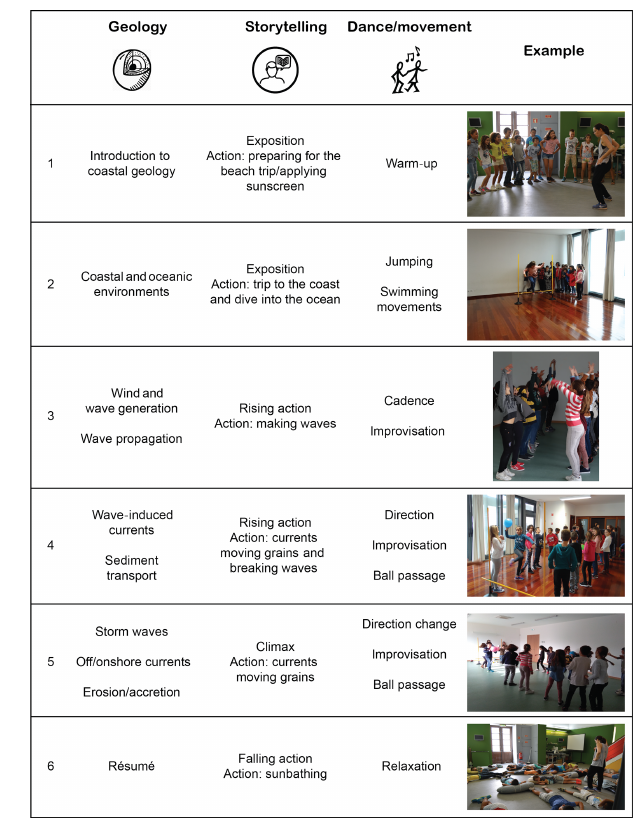
Figure 2. Activity outline: list of scenes (from 1 to 6), related sci- entific contents, associated storytelling moment, and type of dance movements.